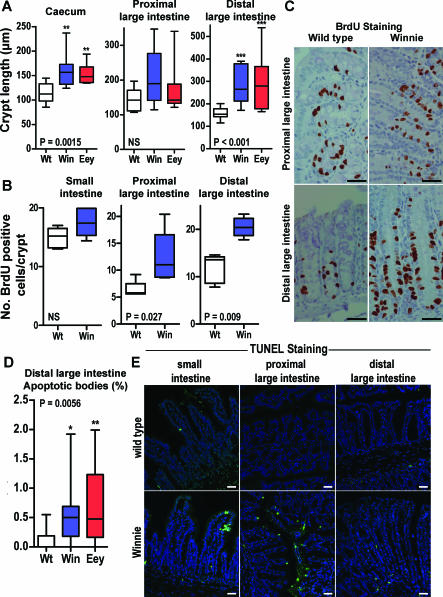
Intestinal Proliferation and Apoptosis Are Increased in Mice with Muc2 Mutations(A) Length of caecal, proximal, and distal large intestinal crypts in wild-type C57BL/6 (WT, n = 12), Winnie (Win, n = 11), and Eeyore (Eey, n = 14) mice.(B) Assessment of incorporation of BrdU in the small intestine, and proximal and distal large intestine of WT (n = 5) and Win (n = 5) mice. For each region of the intestine in each mouse the number of BrdU-positive nuclei was counted in ten crypts (see Materials and Methods).(C) Representative examples of BrdU staining in the proximal and distal colon.(D) Increases in the percentage of apoptotic bodies in distal large intestinal crypts of the same mice as in (A).(E) TUNEL staining showing increased apoptosis in the small and large intestine of Winnie mice (images representative of three mice in each group).Scale bars (C and E) = 50 μm. Statistics: box plots show median, quartiles, and range; (A, B, and D) Kruskal-Wallis nonparametric analysis (p-values shown) with Dunn's multiple comparison test (*p < 0.05, ** p < 0.01, *** p < 0.001); (B) Mann-Whitney U-test, p-values shown. NS, not significant.